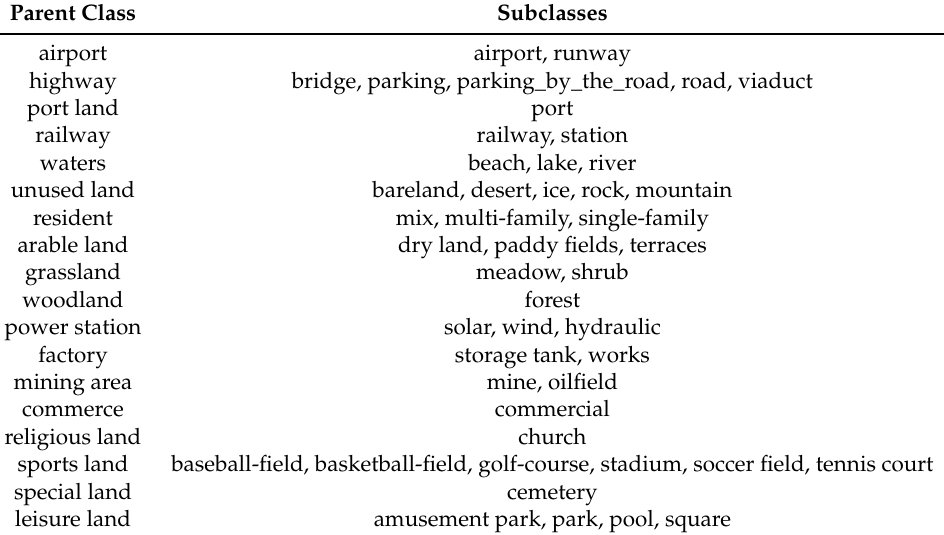
Table 1. Remote sensing image scene category relation network. The left column is the parent class, and the right column is the subclasses contained by the parent class. Parent